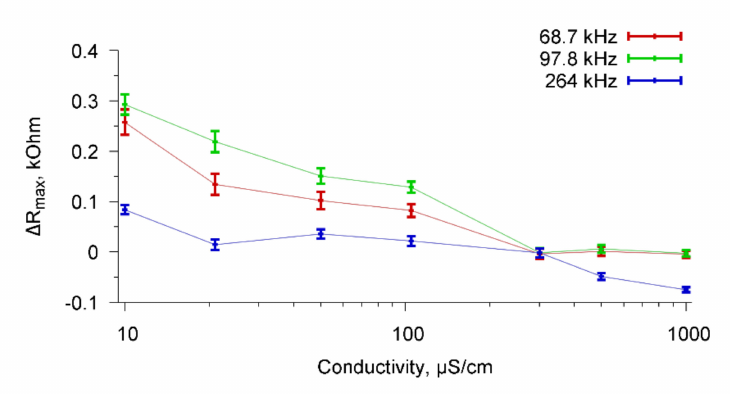
Figure 13. Dependencies of ∆ R max on the conductivity of the bu ff er solution when Abs specific for A. brasilense Sp7 cells was added to the bu ff er with E. coli K-12 cells for resonance peaks near frequencies 67.8, 98.7, and 264